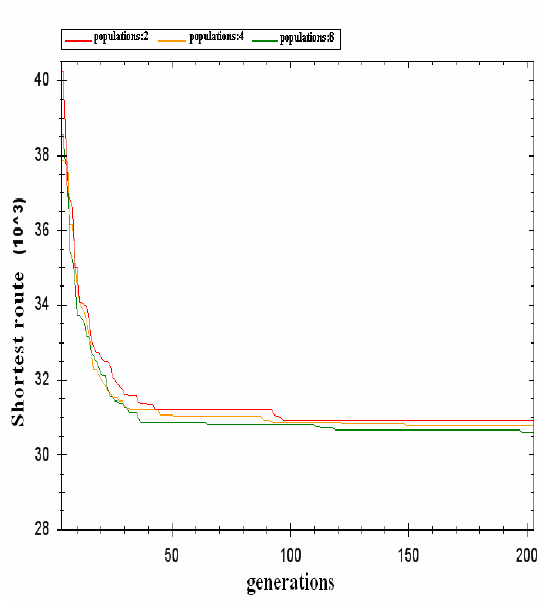
Figure14. The average result 6 of TSP benchmark instances Chn144 by different number of